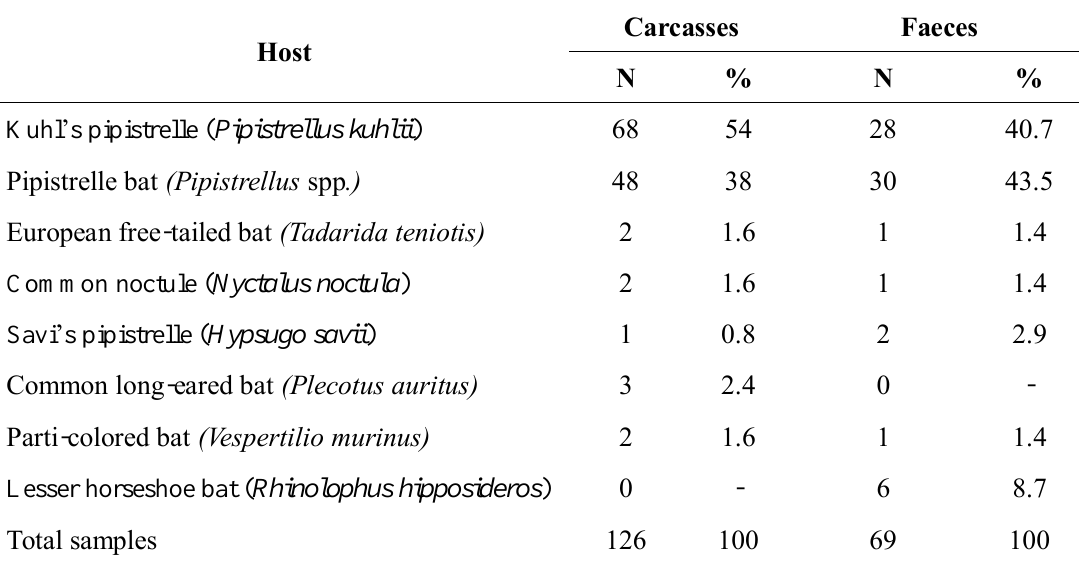
Table 1. List of samples